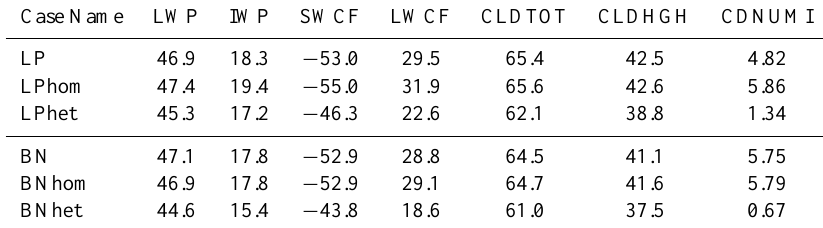
Table 2. Global annual mean cloud properties from sensitivity simulations listed in Table 1 for liquid water path (LWP, gm − 2 ) , ice